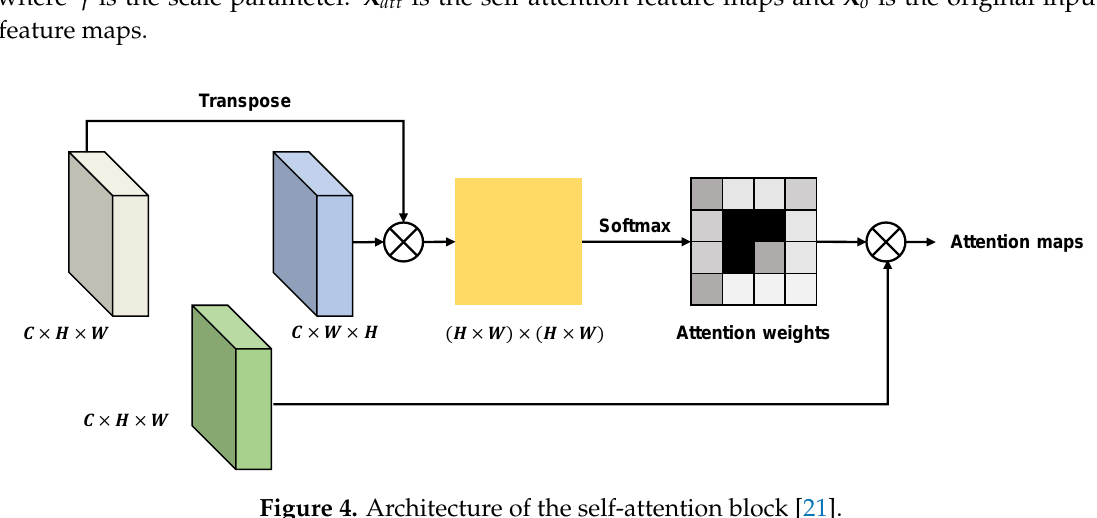
Figure 4. Architecture of the self-attention block